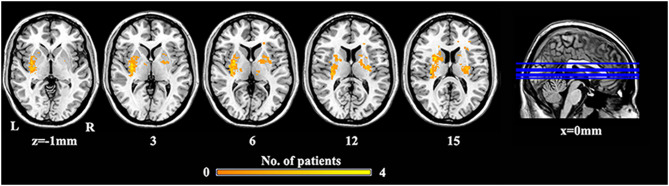
The lesion overlap map of SBG patients. Warm tones represent the superposition of the patient's lesion site. SBG patients, stroke patients with basal ganglia damage; L, left; R, right.